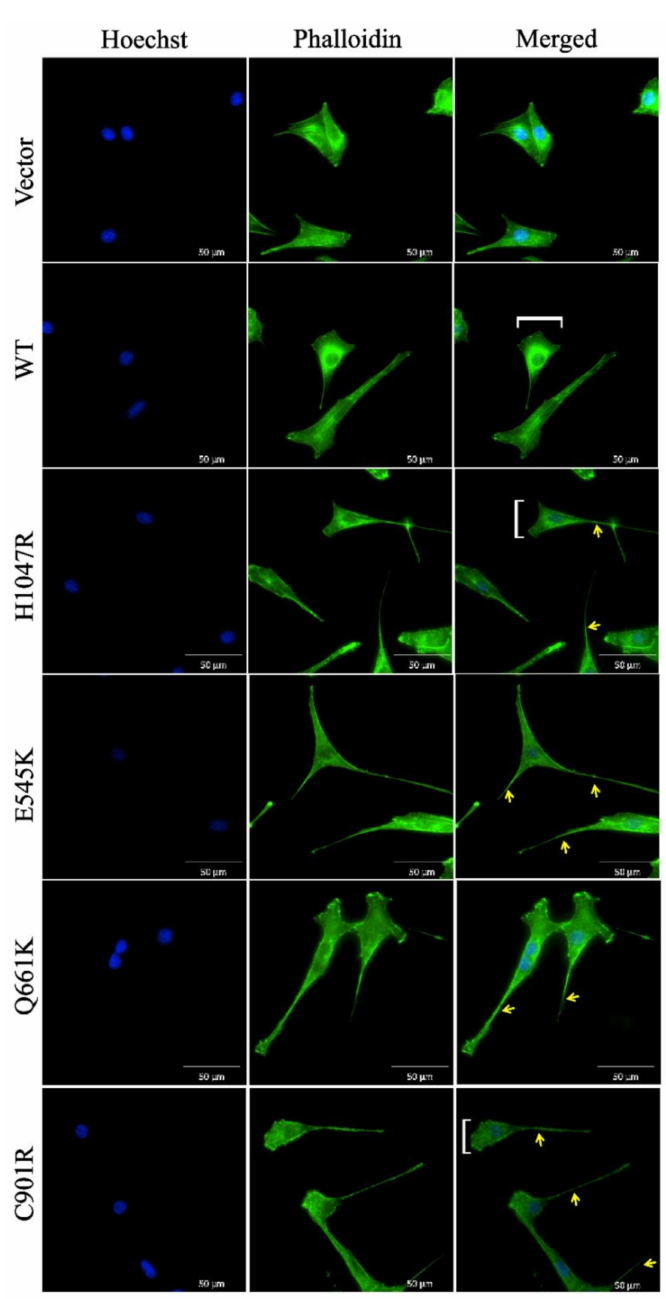
Figure 3. Cytoskeletal reorganization of cells overexpressing wild type, novel, and canonical PIK3CA mutations. White brackets show prominent migrating front. Yellow arrows point to polymerized actin of pseudopod extensions. Scale bar: 50 µ m. Data presented are representative of three independent trials in triplicates. WT: wild